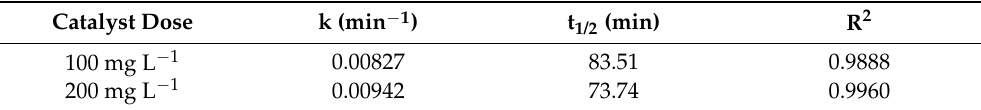
Table 3. Removal kinetic constants (k), half-life values (t 1/2 ) and correlation coefficients (R 2 ) per catalyst